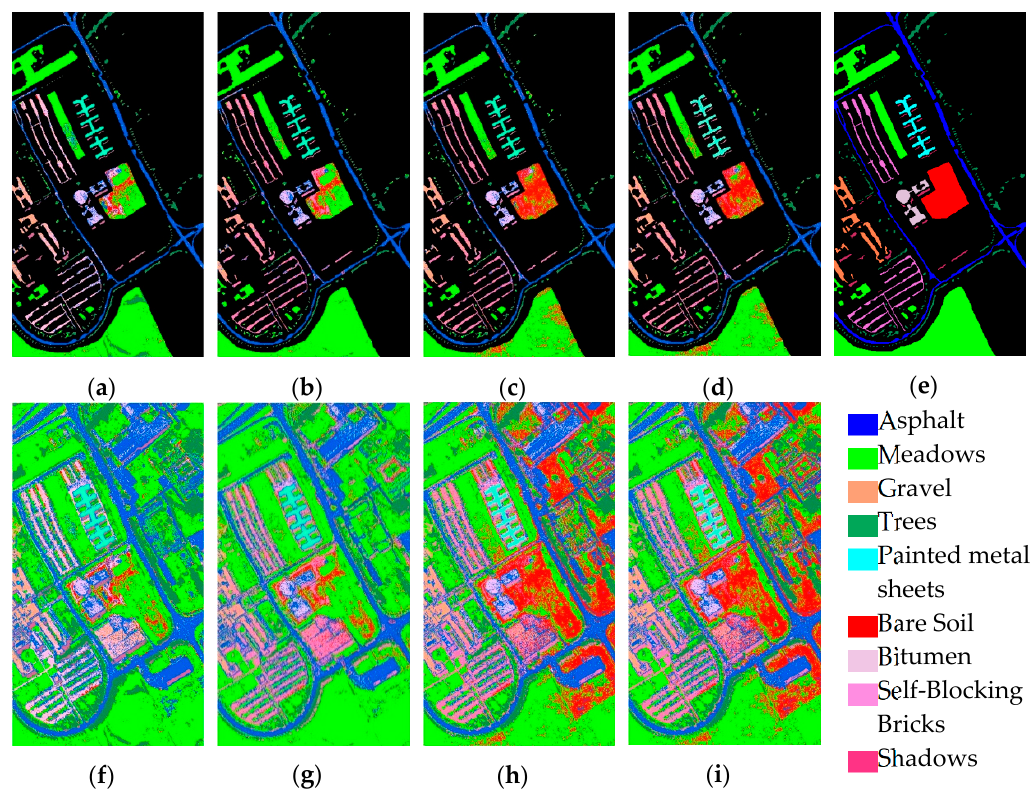
Figure 12. Classification results. ( a ) CNN with an accuracy of 80.14%; ( b ) F–R CNN with an accuracy of 81.26%. The training samples of ( a ) and ( b ) are the original training samples (2144 samples), and the batch training size is two samples. Image ( f ) and ( g ) are the global classification result s corresponding to ( a ) and ( b ) respectively; ( c ) CNN with an accuracy of 85.21%; ( d ) F–R CNN with an accuracy of 86.93%. The training samples of ( c ) and ( d ) are the expanded training samples (20 × 2144 samples), and the batch training size is eight samples. Image ( h ) and ( i ) are the global classification results corresponding to ( c ) and ( d ) respectively; ( e ) ground-truth image. Table 11. Test accuracy of di ff erent training sample